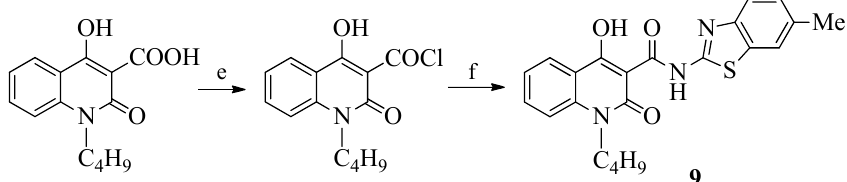
Scheme 1. Synthesis of target compounds. Reagents and conditions: (a) RCOOH, SOCl 2 , CHCl 3 ,